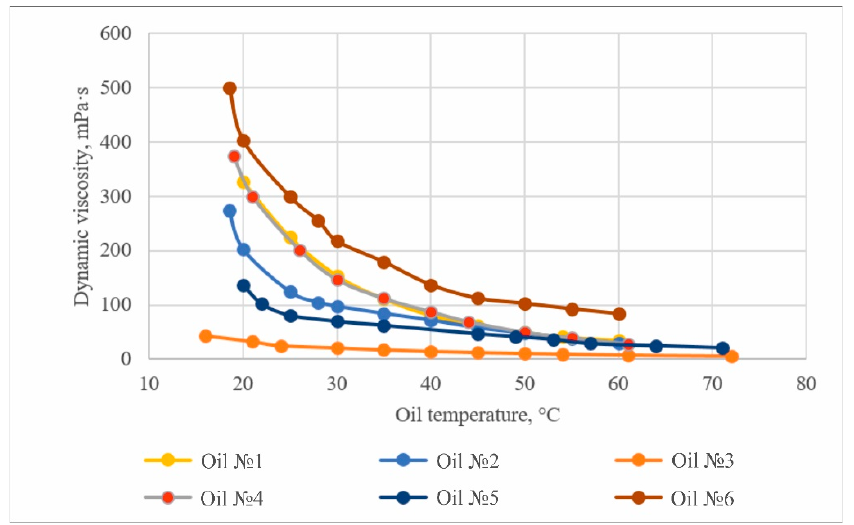
Figure 2. Dependencies of oil dynamic viscosity on temperature for six different oil fields of Nozhovskaya group in Perm Krai.